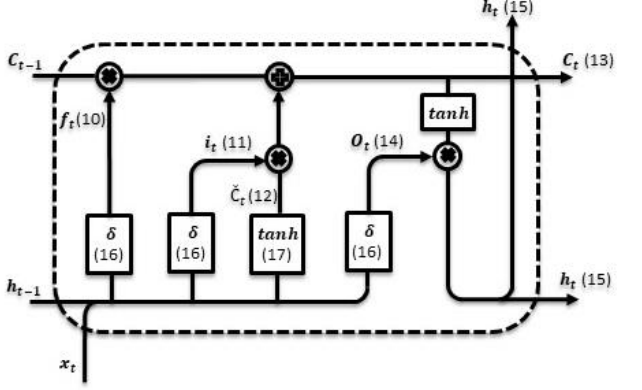
Figure 1. The architecture of LSTM cell. Numbered values correspond to the equation numbers be- low.